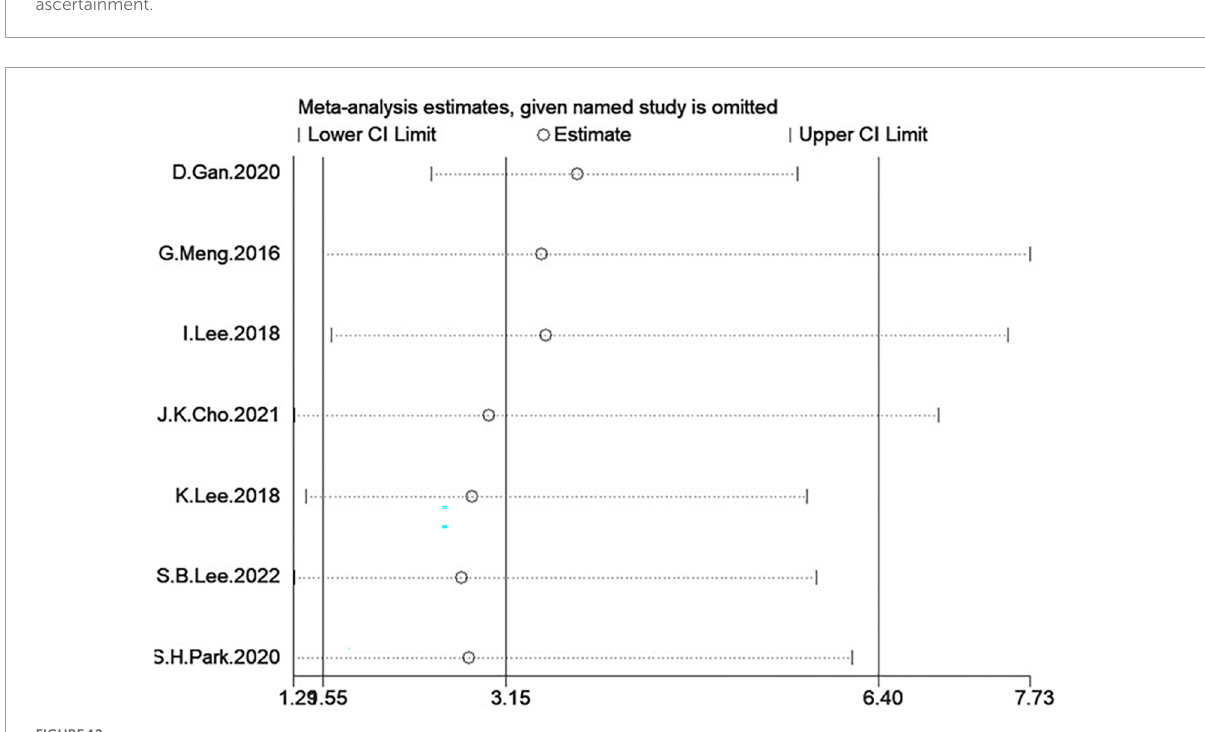
FIGURE12 Sensitivity analysis of low grip strength